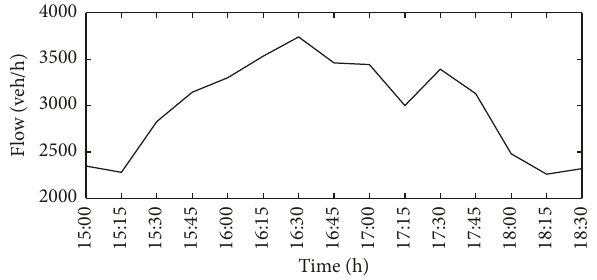
Figure 2: Inflow profile for the simulated scenario. The inflow profile is corresponding to the peak hours on a two-lane urban motorway in